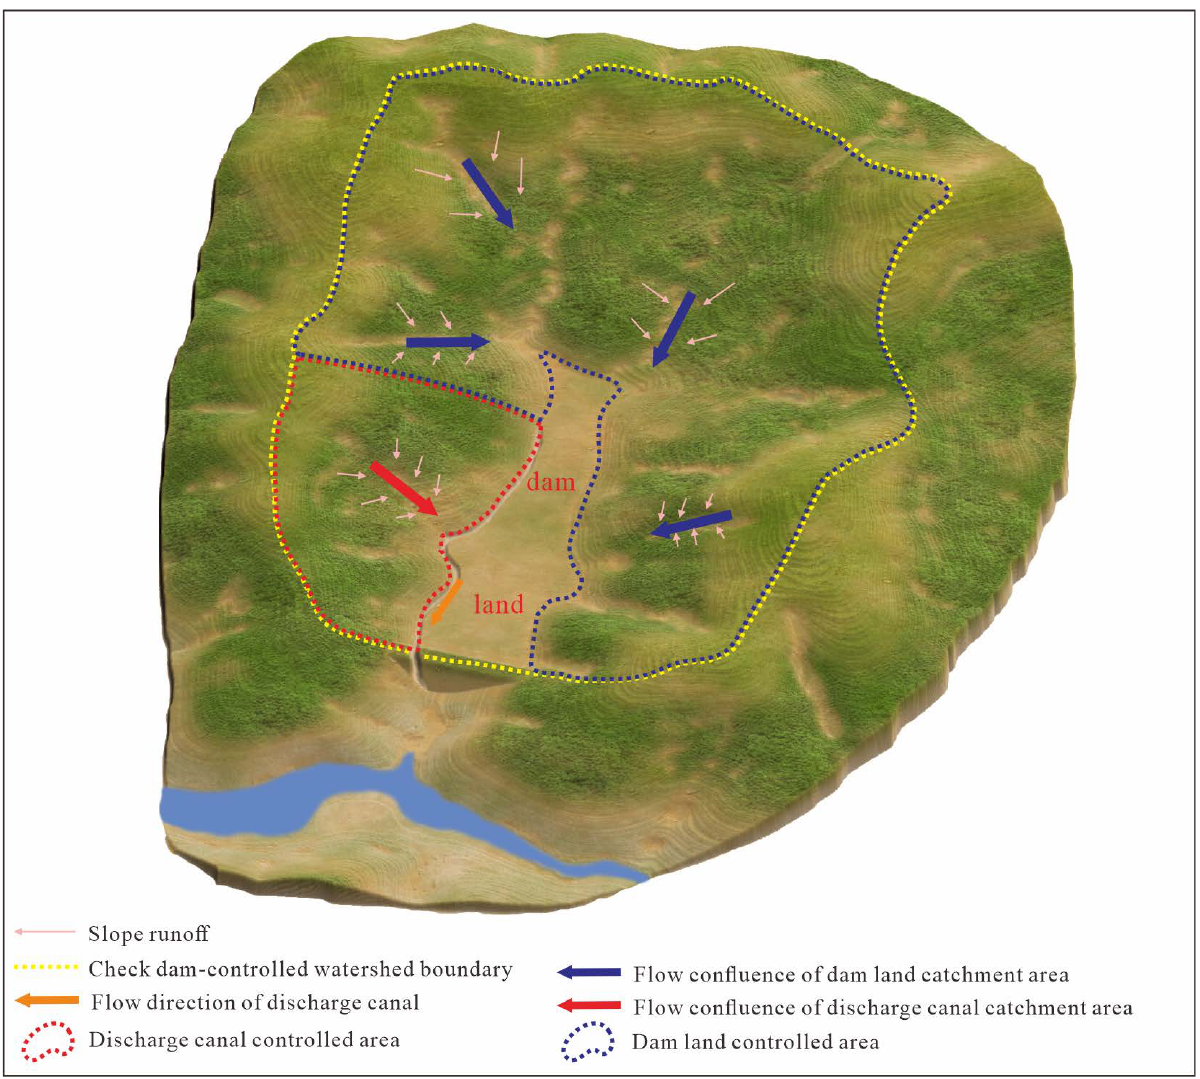
Figure 4. Check dam connected to the downstream channel through the discharge